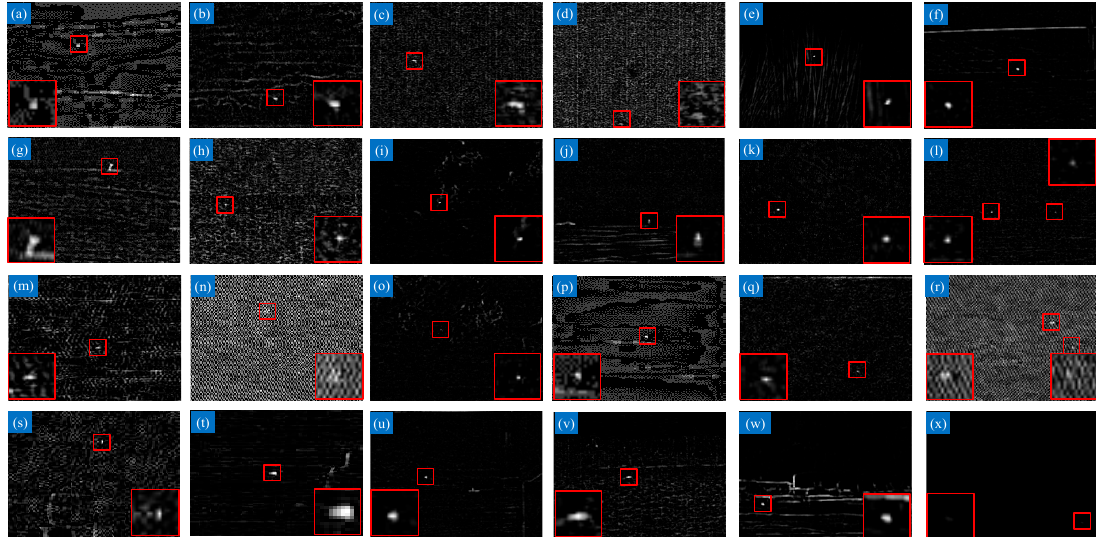
Figure A1. The separated target images of Top-hat under 24 scenes.